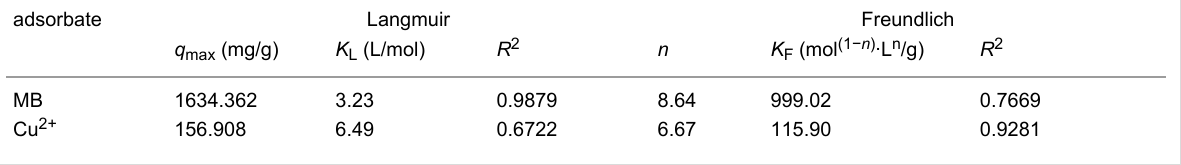
Table 2: Langmuir and Freundlich isotherm model constants and correlation coefficients for the adsorption of MB and Cu 2+ on Lys-GO. adsorbate